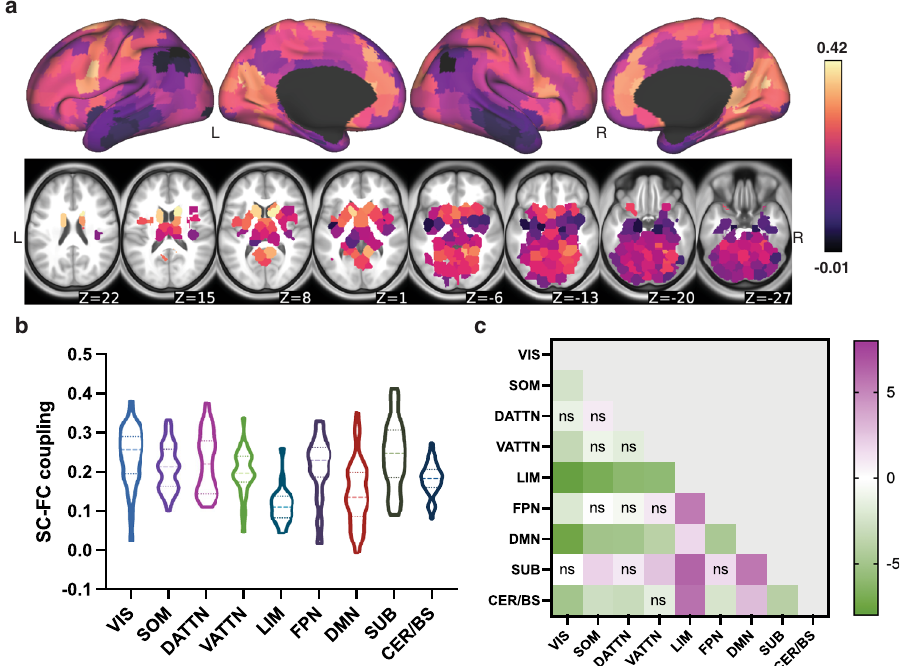
Fig. 2 Regional whole-brain SC – FC coupling varies spatially across the brain. a displays the SC – FC coupling for each cortical and subcortical region in the CC400 atlas. b shows the distribution of SC – FC coupling over regions grouped into nine different networks (the seven cortical networks de fi ned by Yeo et al. 69 , subcortical and cerebellum/brainstem). c shows the t -statistics for all pairwise comparisons of SC – FC coupling across networks, calculated as the network on the y -axis versus the network on the x -axis. One-sided p -values were calculated (see detailed description in the “ Methods ” section). Those comparisons with FDR corrected p > 0.05 are marked with ns . Visual and subcortical networks have higher SC – FC coupling than other networks while limbic and default mode areas have weaker SC – FC coupling than other networks. VIS visual, SOM somatomotor, DATTN dorsal attention, VATTN ventral